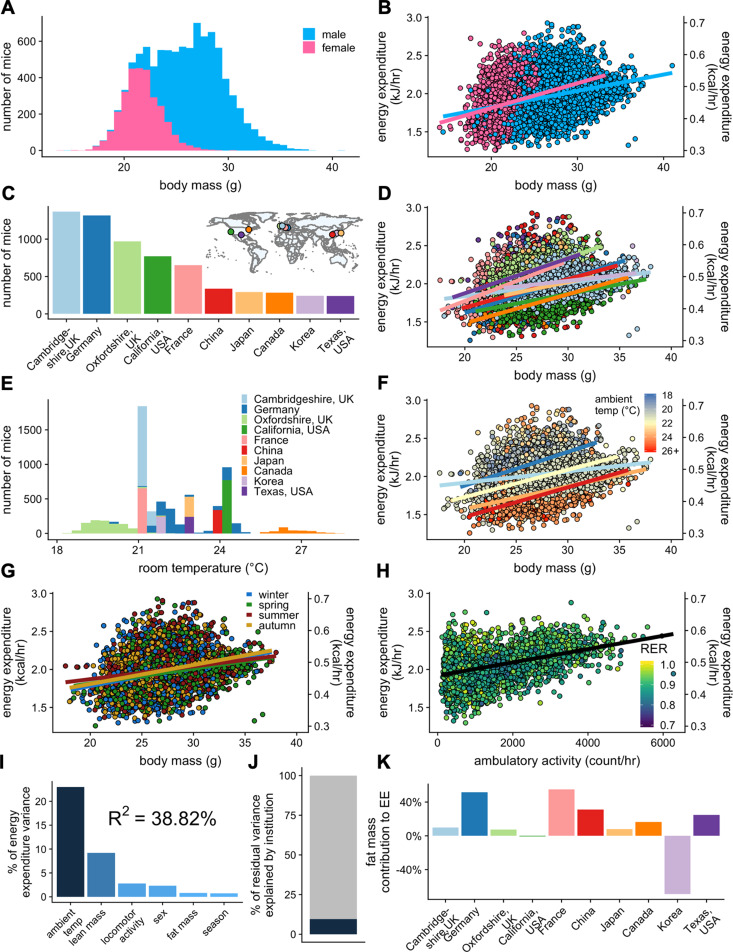
IMPC experiment: institutional variability of metabolic rate.Distribution of body weights for male and female WT C57BL/6N mice from the IMPC database version 10.0 (A). Relationship of EE vs total body mass for female and male WT mice (B). The numbers of male WT mice examined at each of the 10 IMPC sites (C). Inset: geographical locations of IMPC sites. Relationship of EE vs total body mass for male WT mice at each of the 10 IMPC sites (D). Reported ambient temperatures for the experiments performed at each site (E). Relationship of EE vs total body mass in WT males for temperature (F) and season (G). Relationship of EE vs ambulatory activity in WT mice (n = 3886 males) (H). Unaccounted institutional contribution here is approximately 10% (J). The percent variation in EE explained by each of the listed factors (I). Percent contribution of fat mass to EE by site in WT males (K). n = 6469 males and 2889 females unless otherwise specified.Figure 3—source data 1.Pairwise comparisons of slopes in regression plots of EE vs total mass.